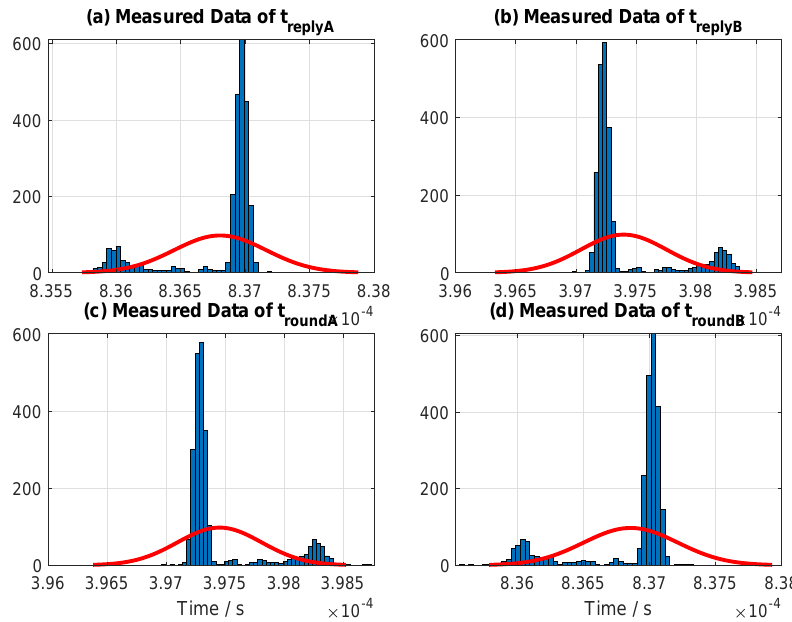
Figure 8. Measured data for fixed reply times used in the experiments for a typical case (Type